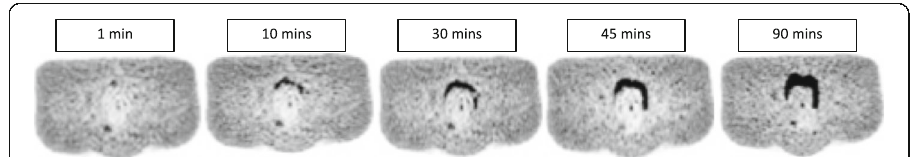
Fig. 8 Demonstration of how inaccurate segmentation can limit the accuracy of the background correction technique. This is shown for a single noise realisation, with a 4-mm post-filter. All images are displayed with the same maximum SUV threshold value